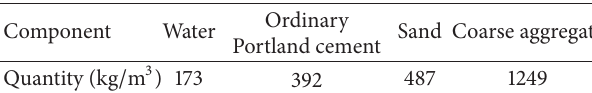
Table 2: Concrete mix proportion. Table 3: Mechanical properties of the reinforcement